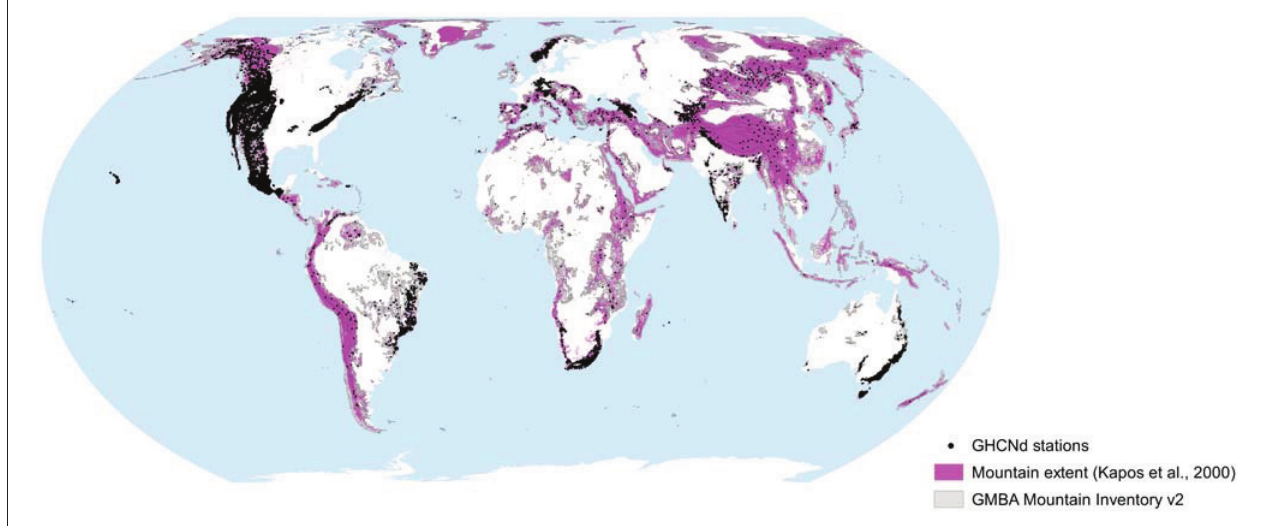
FIGURE 2 | Spatial distribution of GHCNd stations in mountainous terrain (i.e., stations that fall within both the mountain delineation used and one of the GMBA Mountain Inventory polygons) providing measurements of at least one of the four variables— TMIN, TMAX, PRCP , or SNWD —irrespective of record length.